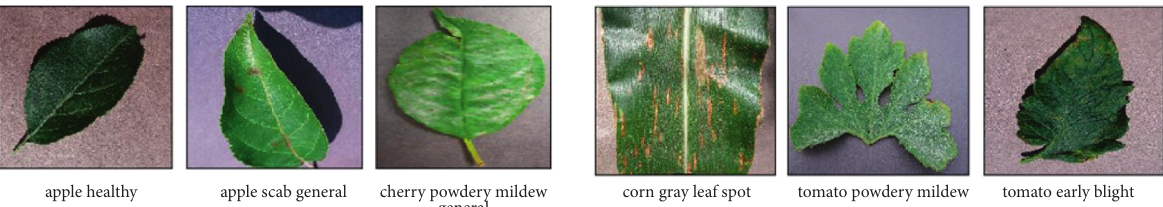
Figure 12: Partial dataset of